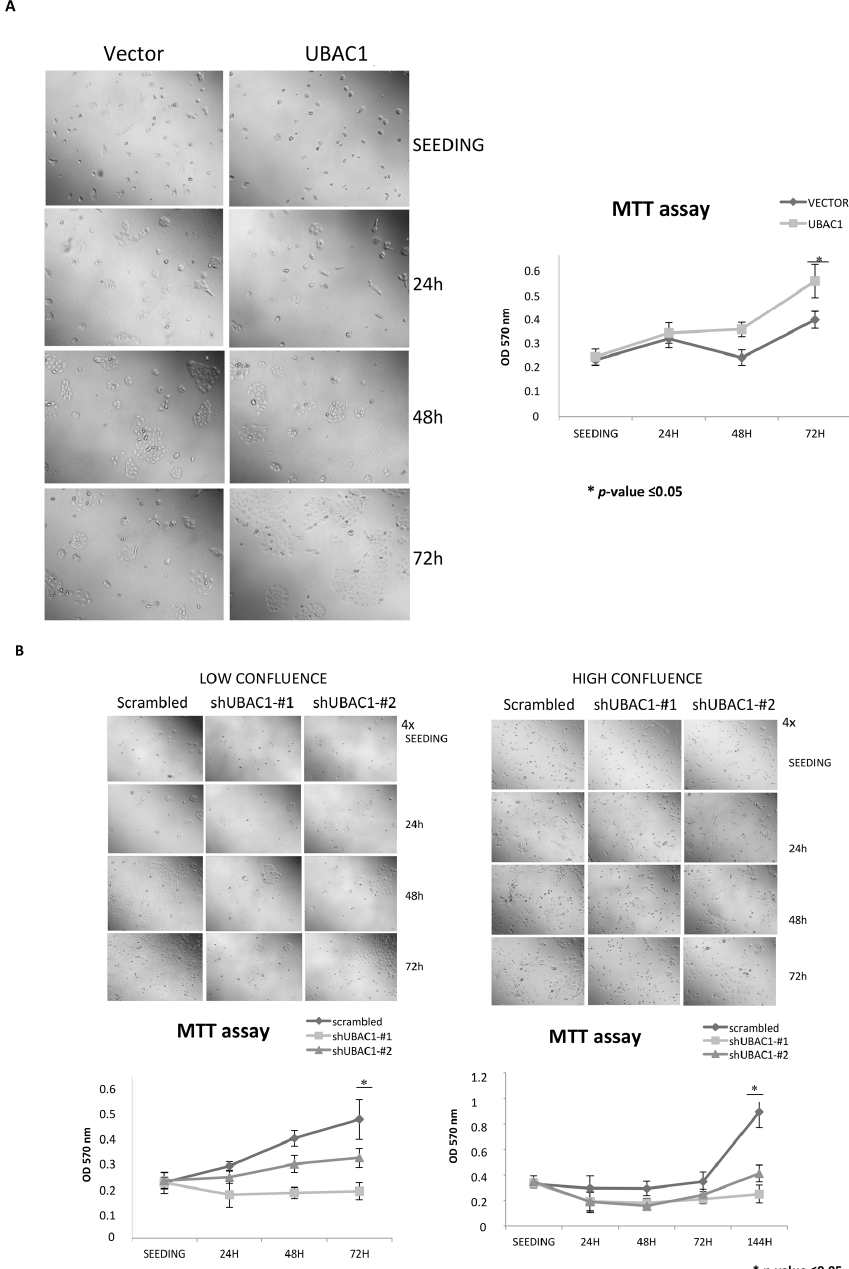
Figure 4. UBAC1 a ff ects viability and proliferation in primary keratinocytes. ( A ) NHEK cells were infected with a lentiviral vector empty or expressing UBAC1. A total of 48 h later, cells were trypsinized, counted in a Neubauer chamber, and 10 4 cells were seeded in each well of a 96-multi well plate. Cell viability was determined by MTT assay at seeding (right after cell attached to the bottom of the well) and 24, 48 and 72 h later. Representative phase contrast micrographs of transfected NHEK are also shown (magnification 4 × ). Graphs show the relative Optical Density at 570 nm at di ff erent time points. Data shown are representative of five independent experiments done in triplicate. Data were analyzed by Student’s t-test (* p -value ≤ 0.05). ( B ) NHEK cells were infected with a lentiviral vector expressing UBAC1-silencing shRNAs or scramble. A total of 48 h later, cells were trypsinized, counted with Neubauer chamber, and 10 4 (lower confluence) or 3 × 10 4 (higher confluence) were seeded in each well of a 96-multi well plate. MTT data and micrographs and statistical analysis were performed as in Figure 4A. When seeded at higher confluence, di ff erences between UBAC1-silenced NHEK and control cells are evident only 144 h after seeding (micrographs not